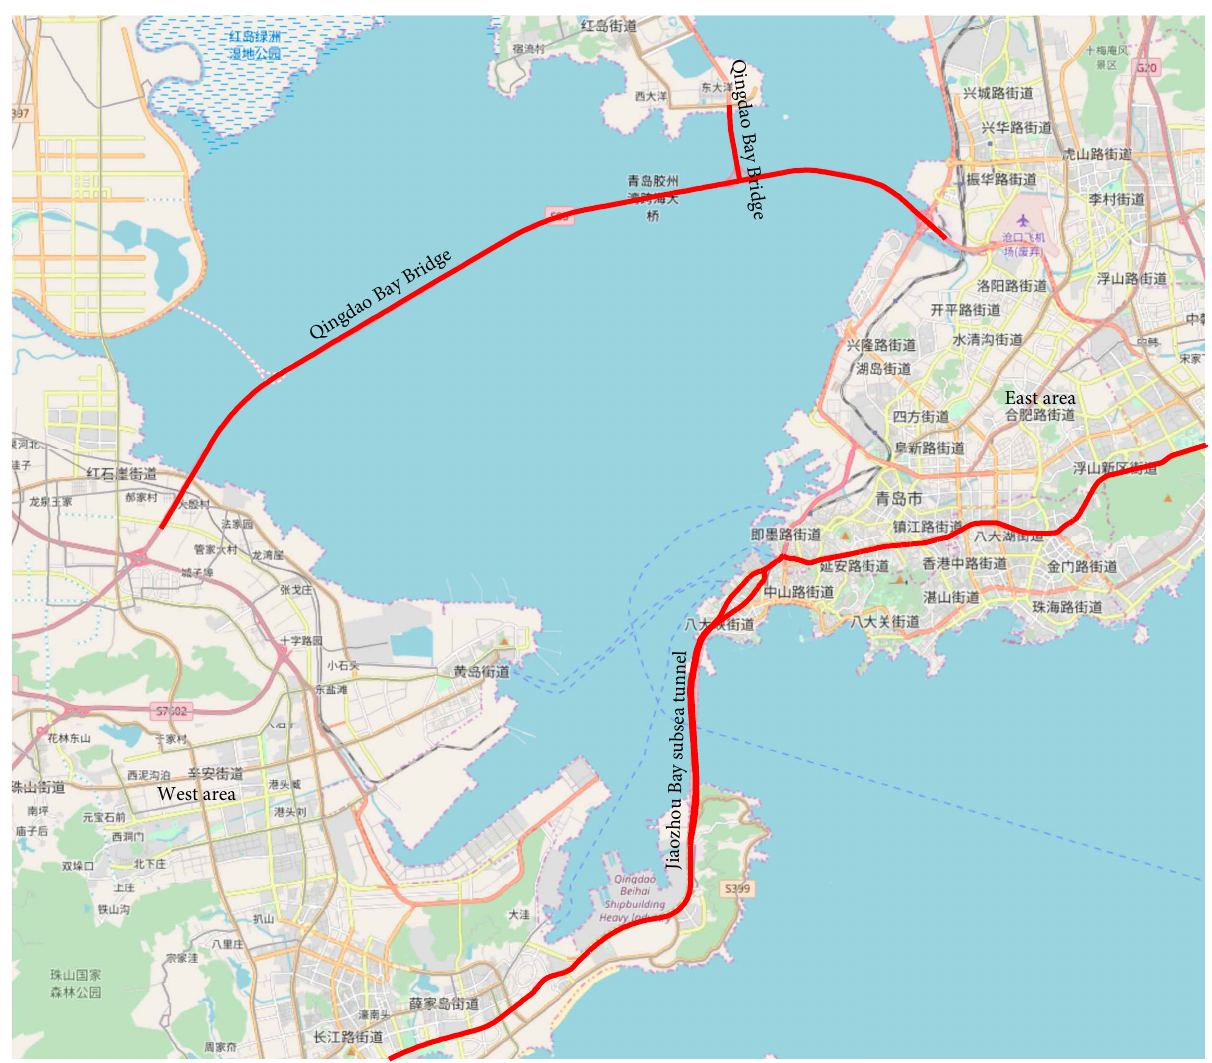
Figure 9: Qingdao Bay Bridge and Submarine